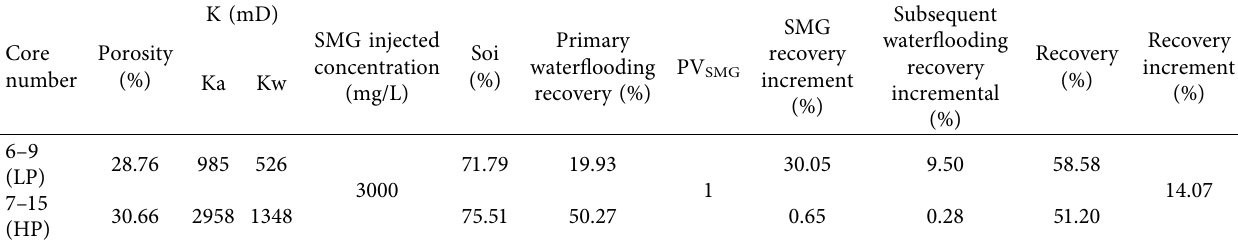
Table 1: Oil displacement effect of submillimeter-scale SMG aqueous solution.